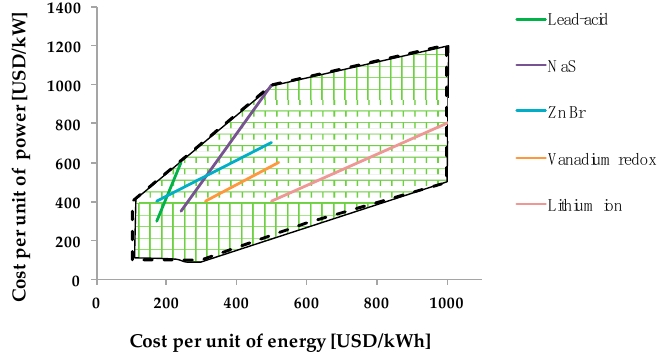
Figure 2. Energy and power costs for BESS considered in the optimization.